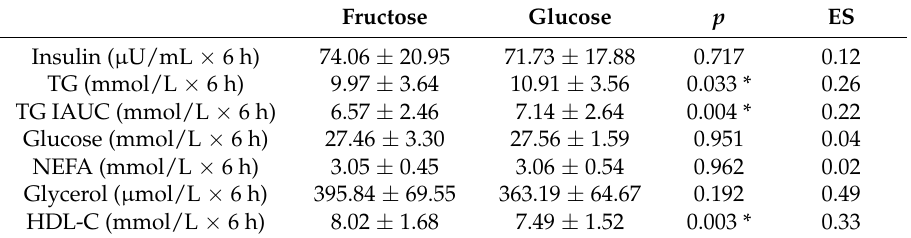
Table 2. The plasma and serum sample concentrations before